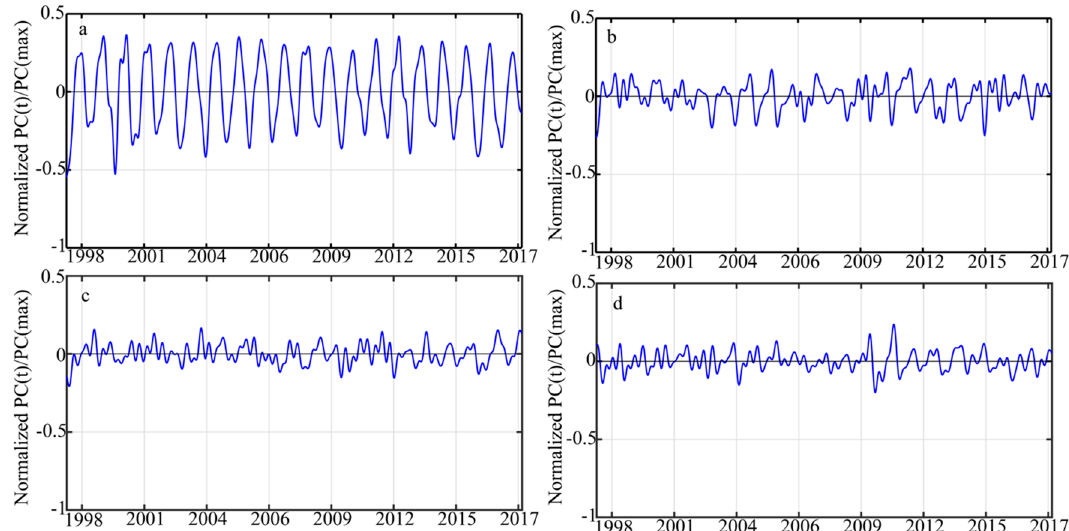
Figure 10. Time series of the amplitudes of the four dominant EOF modes for average SWH from 1998 to 2018. ( a ) The first mode; ( b ) the second mode; ( c ) the third mode; and ( d ) the forth